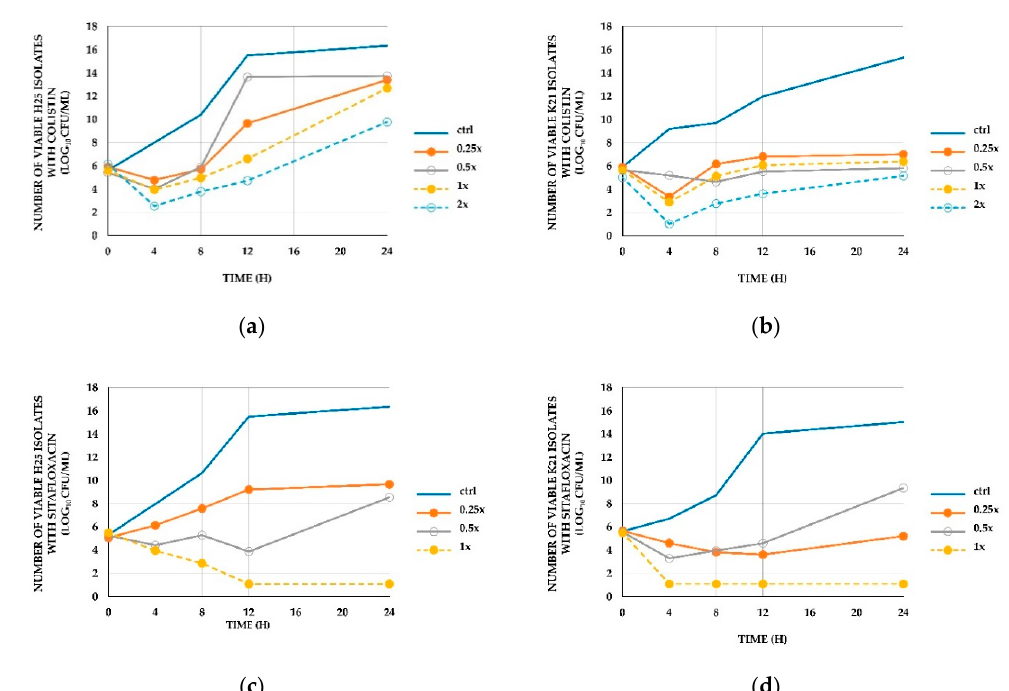
Figure 1. Time-kill curves of A. baumannii clinical isolates. Time-kill studies of ( a ) the H25 isolate with colistin, ( b ) the K21 isolate with colistin, ( c ) the H25 isolate with sitafloxacin, and ( d ) the K21 isolate with sitafloxacin. The number of viable bacteria from the start of the experiment is shown. Ctrl represents control isolates (no antimicrobial agents). The dark blue solid lines represent control isolates. The orange solid lines with filled circles represent a concentration of 0.25× MIC, the grey solid lines with open circles represent a concentration of 0.5× MIC, the yellow dashed lines with filled circles represent a concentration of 1× MIC, and the blue dashed lines with open circles represent a concentration of 2× MIC.